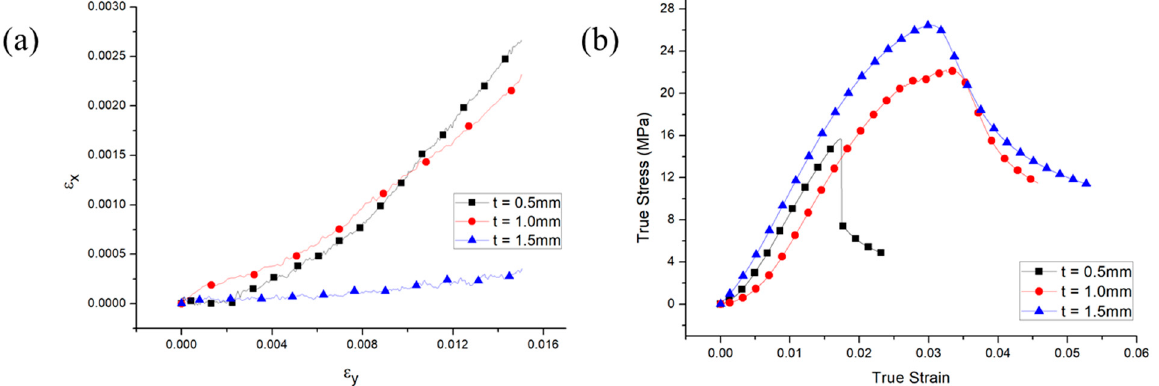
Figure 5. The ε x - ε y curve and stress-strain curve of SLM auxetic structure of different pillar thickness. ( a ) ε x - ε y curve ( b ) Stress-strain curve.